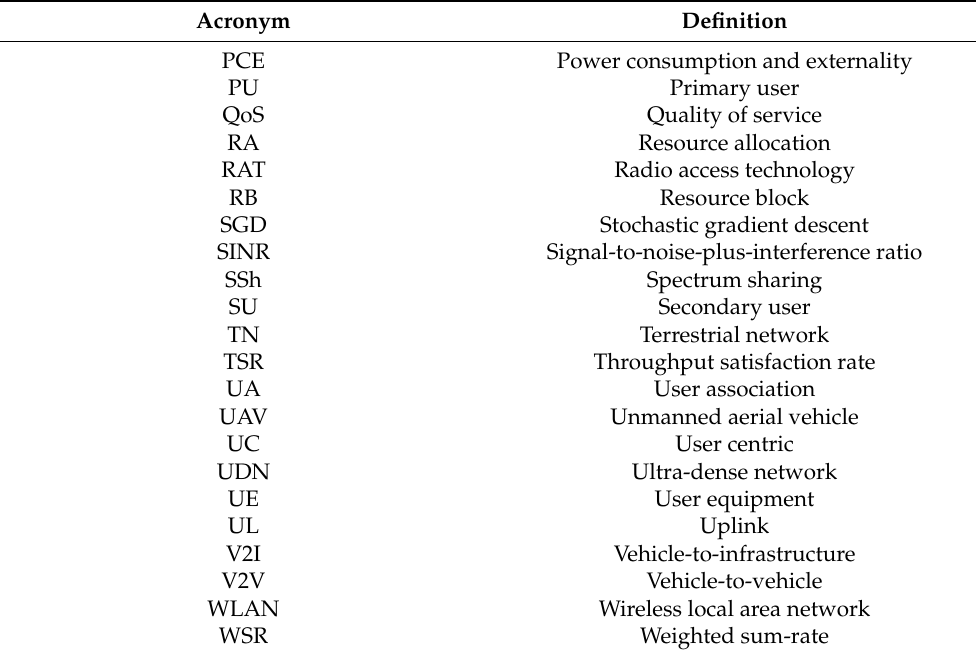
Table 2. Table of acronyms.